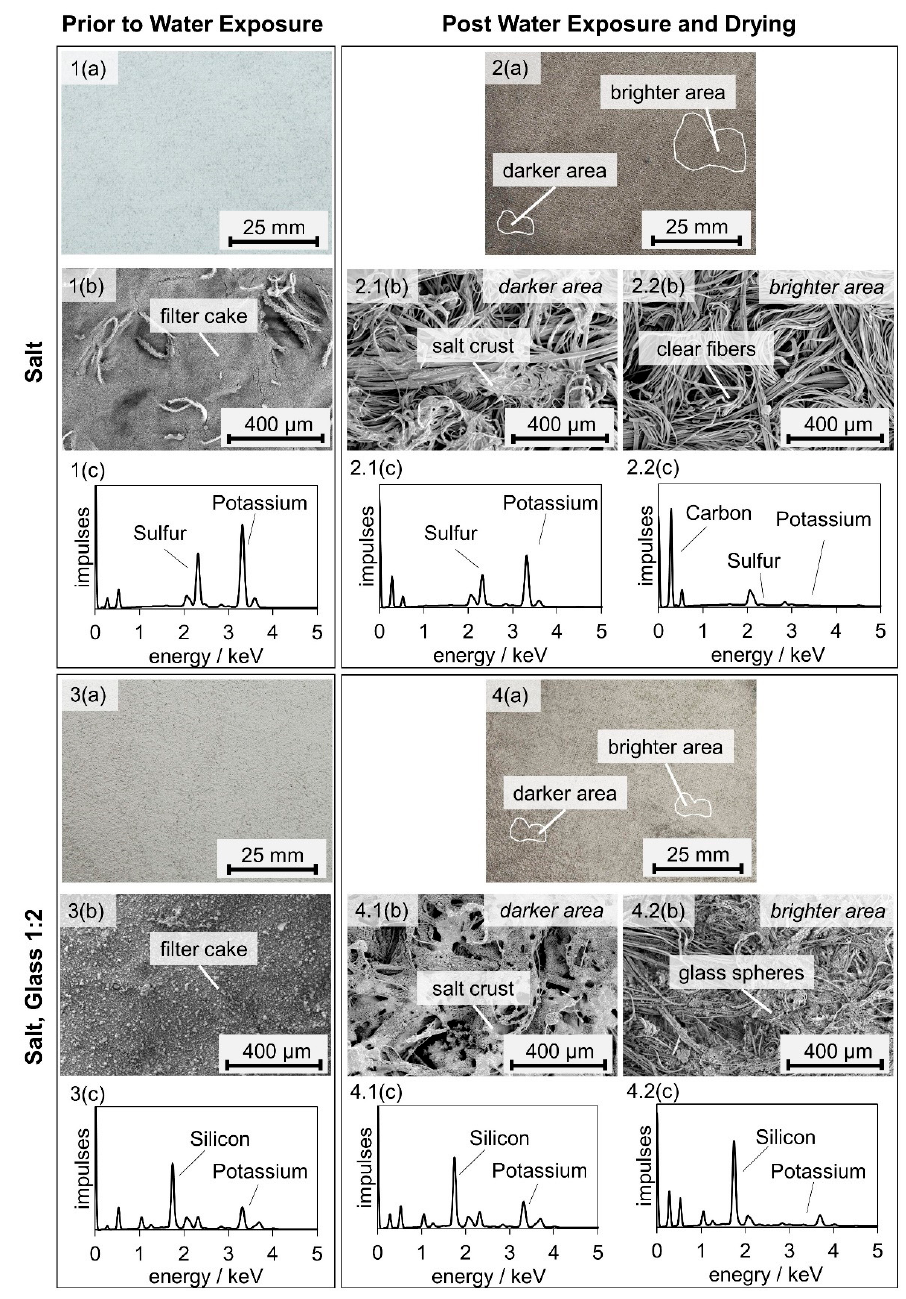
Figure 14. Photos ( a ), SEM images ( b ) and full-sample EDX area scans ( c ) of the raw gas surface of the salt-laden filter before ( 1 ) and after ( 2 ) water exposure and drying, and the filter loaded with a mixture of salt and glass particles before ( 3 ) and after ( 4 ) water exposure and drying. Before exposure to water mist, both filters are evenly covered with a filter cake (Fig- ure 14(1a,3a)). In the case of the salt-laden filter, individual fibers are sticking out of the filter cake, indicating that this filter cake has a smaller thickness (Figure 14(1b)). After exposure to water mist, the salt formed crusts around individual fiber bundles of the salt- laden filter (comp. Figure 8). On the filter with salt and glass, both glass spheres and salt